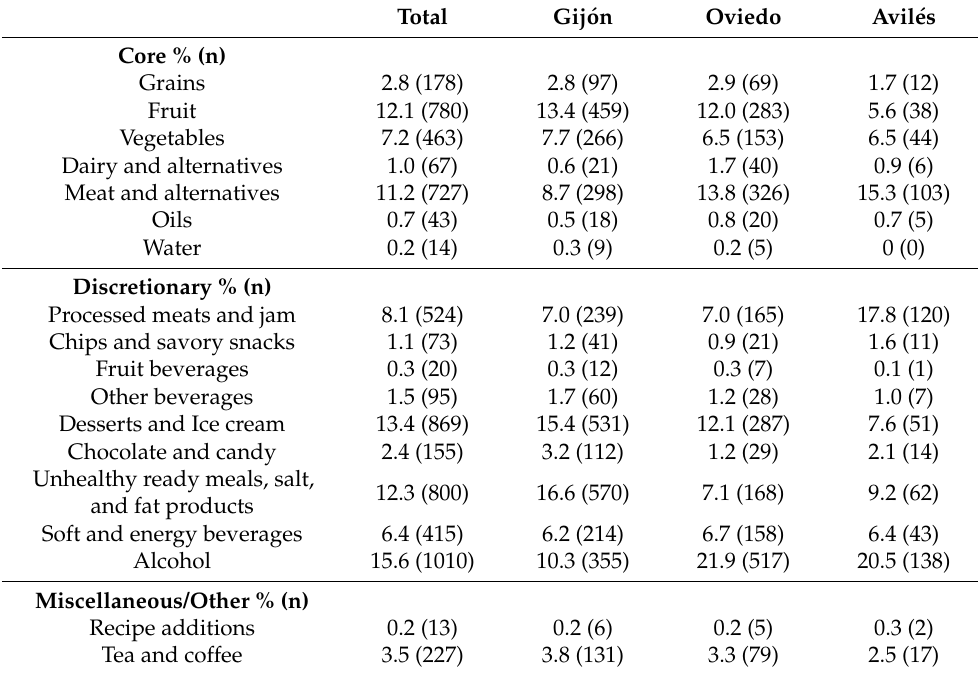
Table 2. Percentage of type of minor foods and beverages around the schools classified by